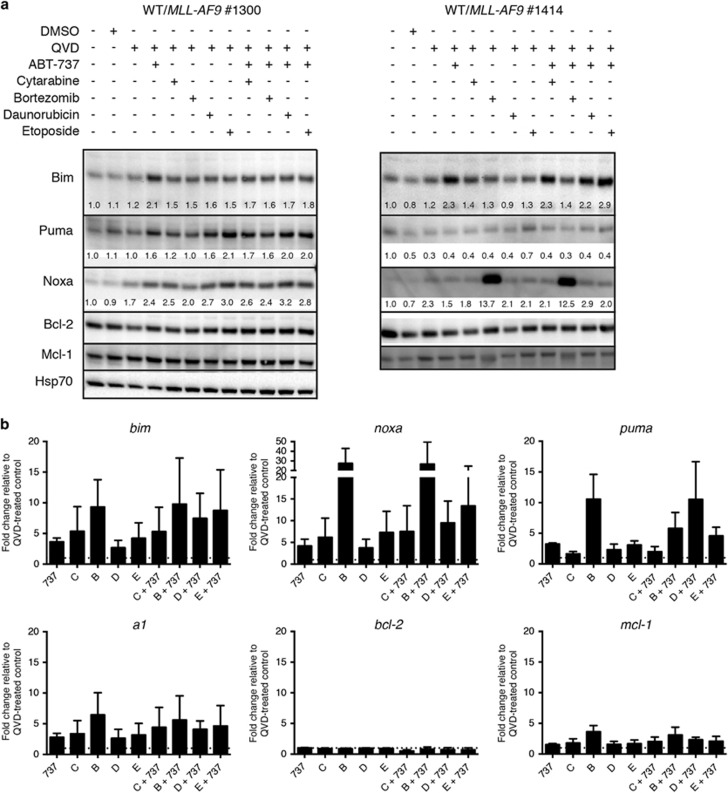
Expression of Bcl-2 family members following treatment. Expression of Bcl-2 family members in cultured primary WT/MLL-AF9 AMLs following treatment with cytotoxic agents. (a) Western blot analysis of protein expression in AMLs #1300 and #1414 after 6 h treatment with the indicated drugs. Numbers below bands indicate the intensity of each lane relative to the untreated control for each antibody. Quantitation was performed using Image Lab software. (b) qPCR analysis of RNA expression in AMLs #1300, #1411 and #1601 after 3 h treatment. ΔΔCT values normalized to HMBS control and made relative to cells treated with QVD only to determine drug-induced fold change. Data represents mean fold change±S.E.M., with dashed line indicating a value of 1; note the different axis for noxa expression. Comparable PCR analyzes of BH3-only gene KO/MLL-AF9 AMLs are summarized in Supplementary Figure S7. AML cell lines maintained in culture in IMDM with 10% FCS and supplemental IL-3 (Materials and methods section) were treated with 600 ng/ml cytarabine [C], 25 nM bortezomib [B], 200 ng/ml daunorubicin [D], 300 ng/ml etoposide [E], either alone or in combination with 1 μg/ml ABT-737 [737] as indicated, in presence of the pan-caspase inhibitor QVD-OPH (25 μM)